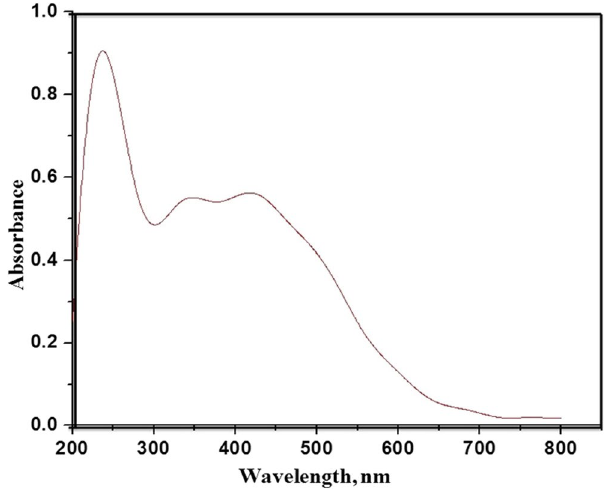
Figure 5. UV-Vis absorption spectra of Ti-ZTBF.